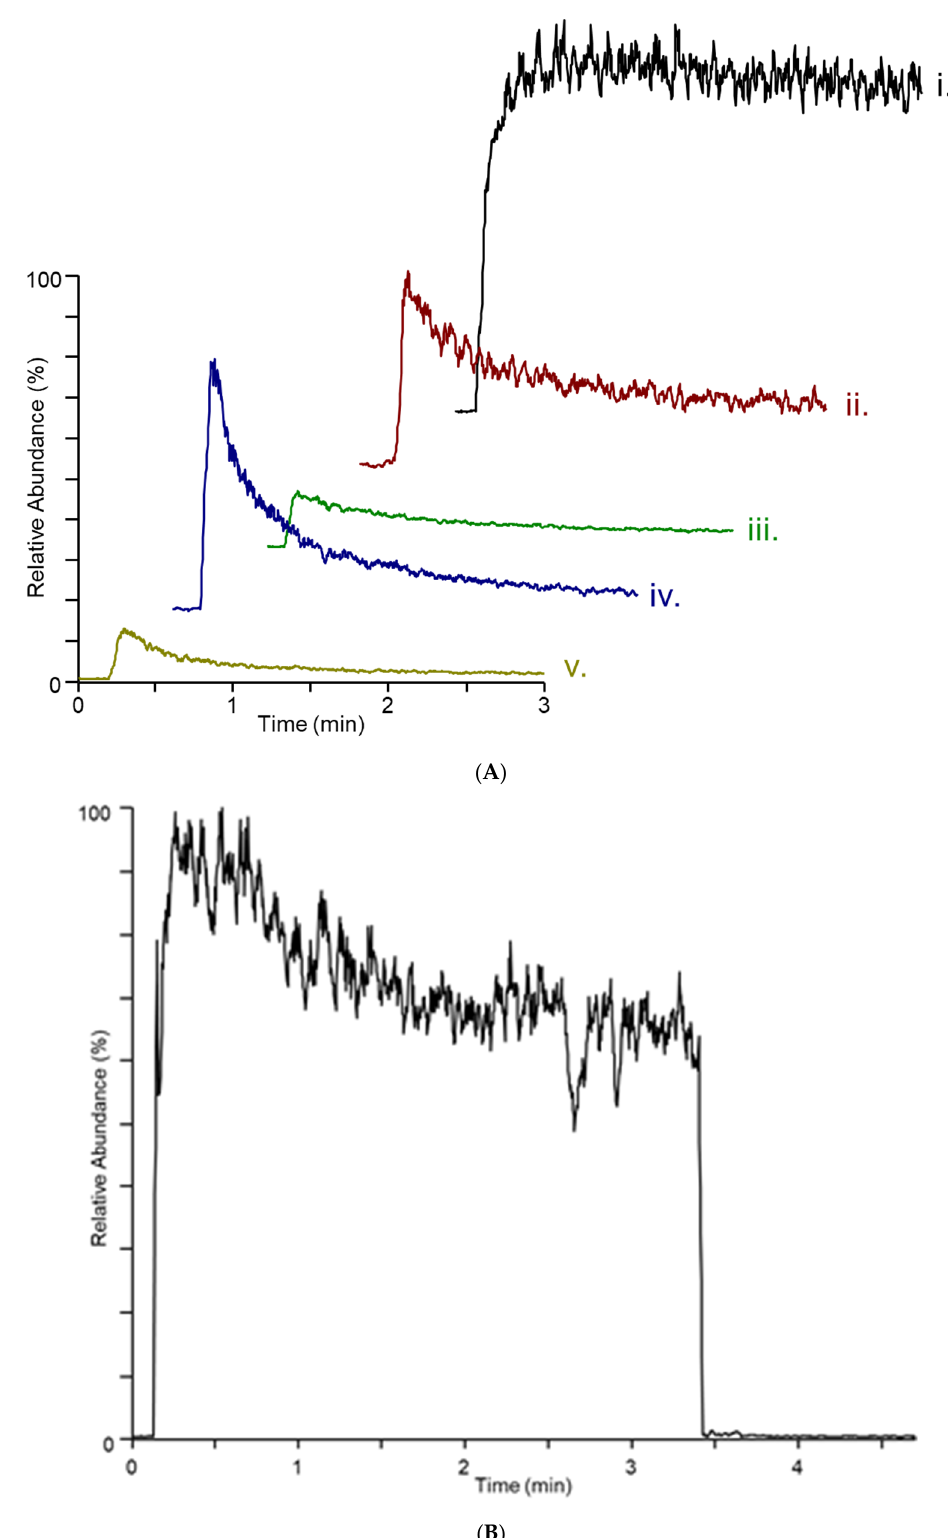
Figure 3. Plots of extracted ion intensity versus time for ( A ) m/z 165 from (i.) F. verticillioides, (ii.) F. virguliforme , (iii.) F. graminearum (iv.) F. scirpi , and (v.) F. avenaceum and ( B ) m/z 195 from F. verticillioides on cracked maize. The full scale for count intensity for plot ( A ) is 1.26 × 10 7 and for plot ( B ) is 1.88 × 10 5